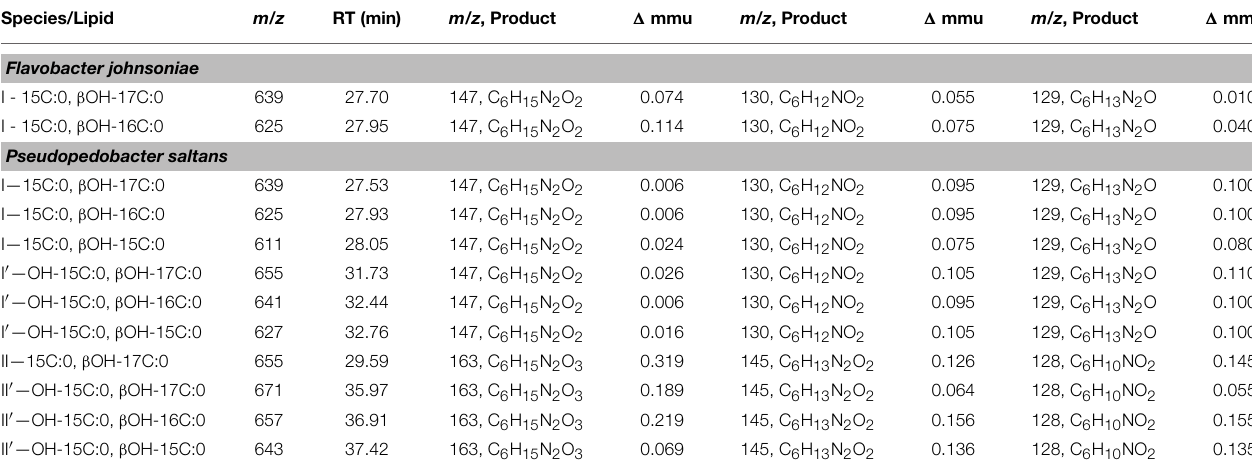
TABLE 1 | Elemental composition of amino acid containing lipid fragmentation products observed by high performance liquid chromatography-high resolution accurate mass/mass spectrometry (HPLC-HRAM/MS) in the lipid extracts of Flavobacterium johnsoniae and Pseudopedobacter saltans .